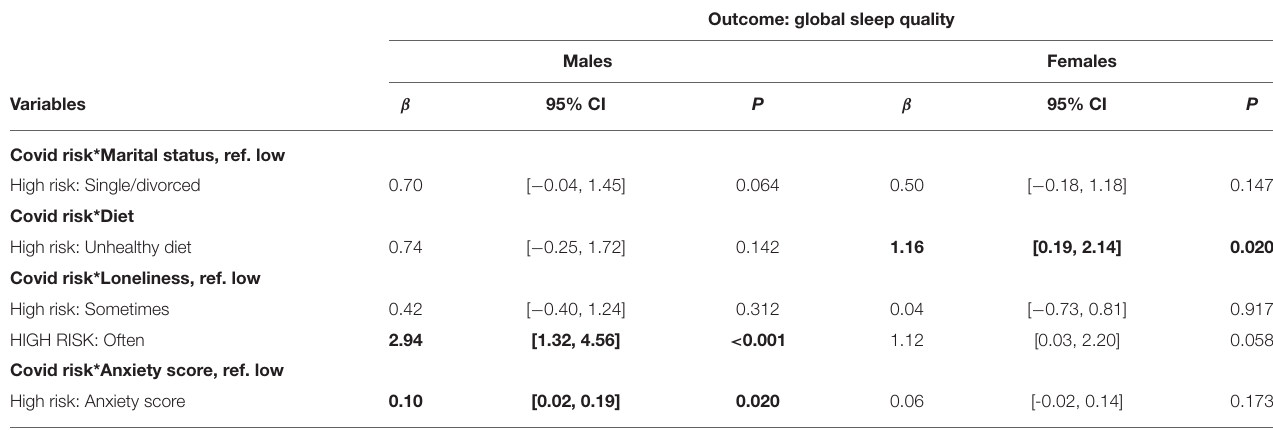
TABLE 4 | Sex-stratified analysis showing modification of relationship between COVID-19CEV status and sleep quality during lockdown, by distinct lifestyle and psychosocial predictors of sleep, in males and females.